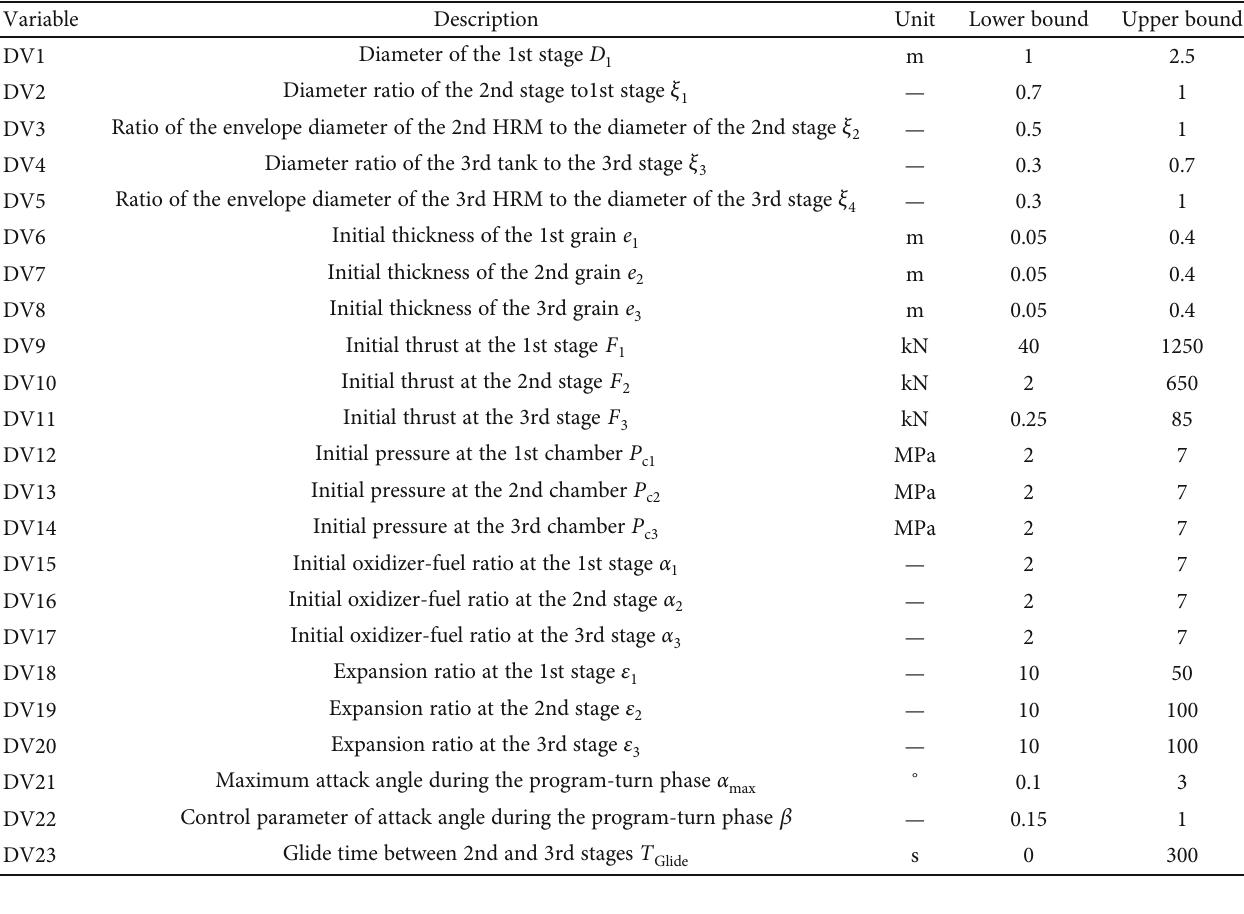
Table 4: Description and ranges of variables.